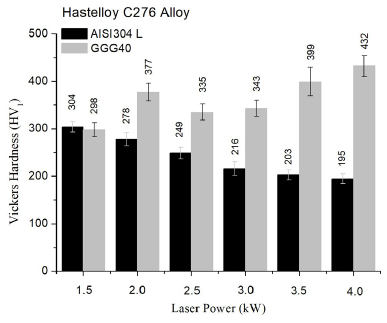
Figure 13. Vickers hardness of the coatings.